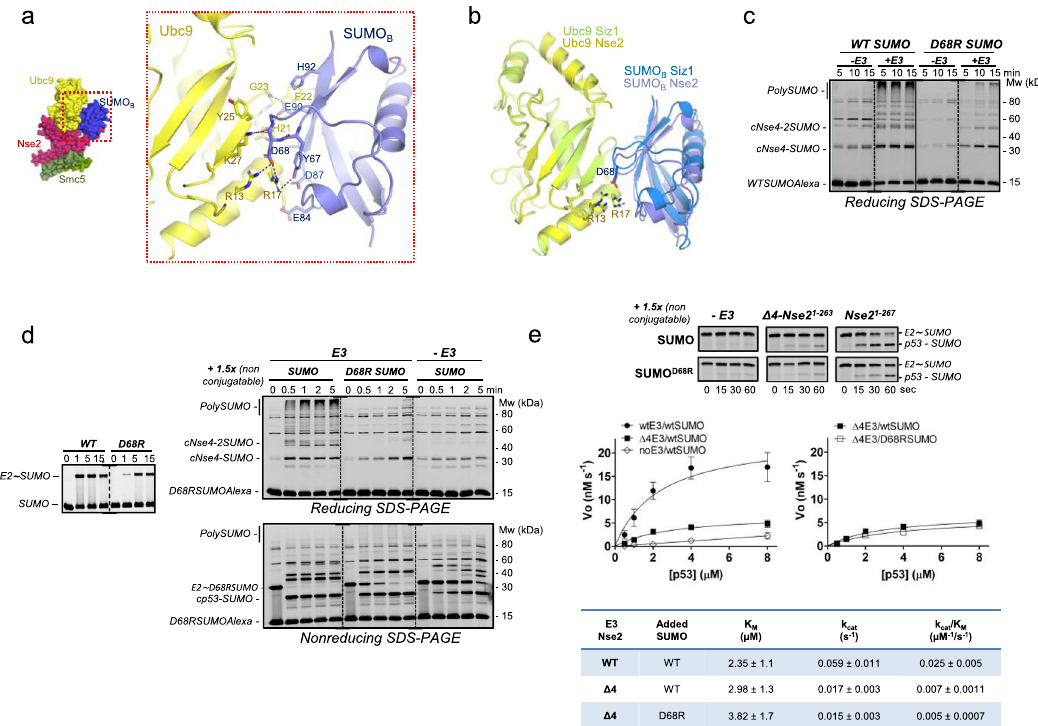
Fig. 4 The SUMO B backside is fi xed by the C-terminal SIM2 of Nse2. a Cartoon representation of the interaction between Ubc9 and SUMO B (Asp68 SUMO makes electrostatic contacts with Ubc9 ’ s Arg13 and Arg17). b Structural alignment of Ubc9 in Nse2 and Siz1 complexes (5JNE), revealing a displacement of the backside SUMO B . c . Multiple-turnover SUMOylation reactions using of wild type or D68R SUMO in the absence or presence of yeast Nse2/Arm-Smc5 E3 complex at 30 °C. d Single-turnover SUMOylation reactions stopped by EDTA using D68R SUMO D ~E2 thioester by yeast